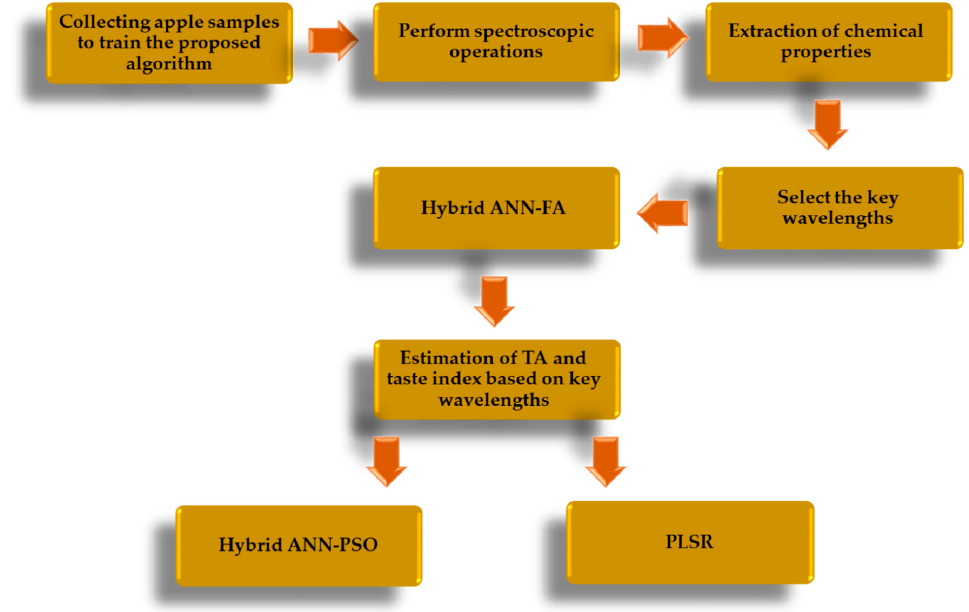
Figure 1. Flowchart of different stages of training the proposed algorithm for non-destructive estimation of chemical properties of titration acidity and taste index of Gala cultivar.